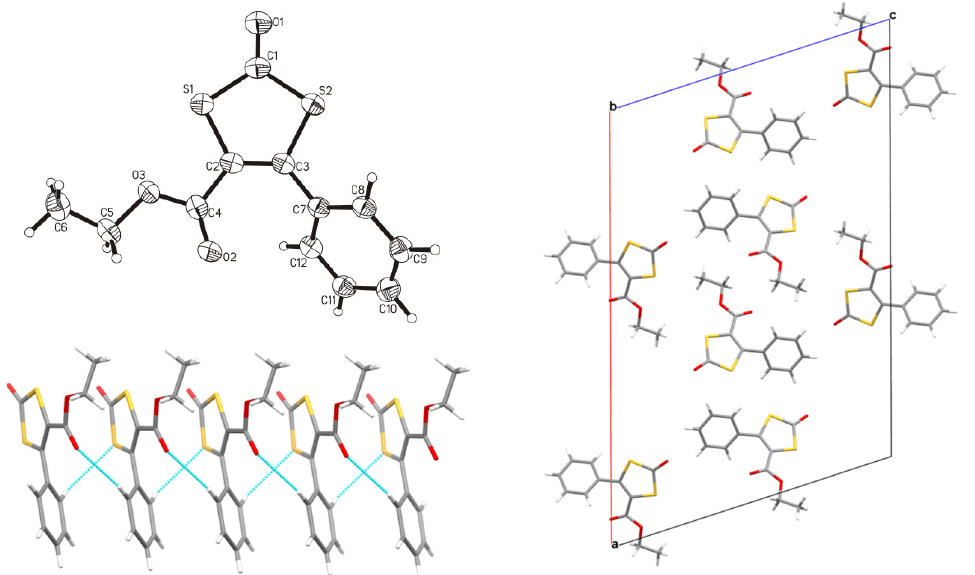
Figure 1. Top left: Molecular structure of 3 shown with 50% probability thermal ellipsoids. Selected bond lengths (Å) and angels (°): [C1–O1: 1.221(5), S1–C1: 1.761(4), S1–C2: 1.756(4), S2–C1: 1.764(4), S2–C3: 1.747(4), C2–C3, 1.353(5)]; [C2–C3–S2: 96.10(19), C3–C2–S1: 97.27(19), S1–C1–S2: 123.8(3)]. Bottom left: Non-classical intermolecular hydrogen bonding interactions (shown in light blue) forming chains, which protrude along the crystallographic b -axis (carbon: gray, hydrogen: white, oxygen: red, and sulfur: yellow). Right: Projection view of the crystal packing along the crystallographic b- axis.